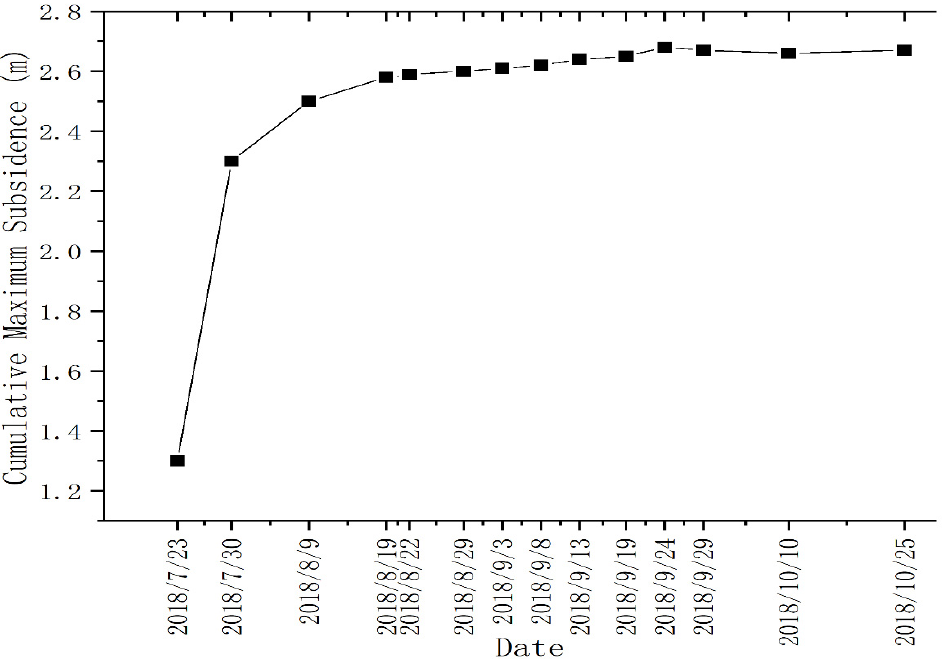
Figure 15. Time series maximum cumulative subsidence plot.